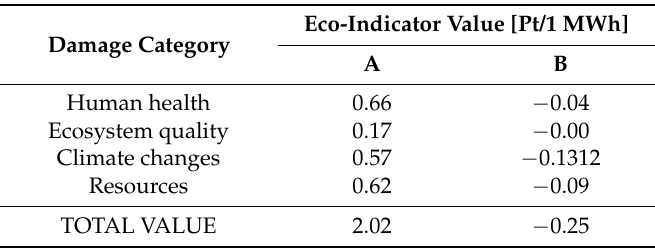
Table 2. Negative and positive environmental impact of the examined biogas plants expressed as weighted results of damage category